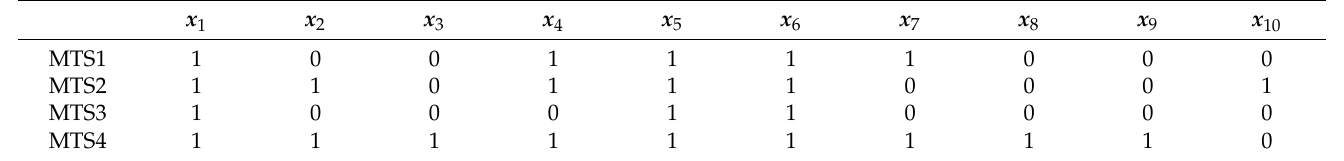
Table 16. Feature variable selection results of BT-MTS of the Page-blocks data set.